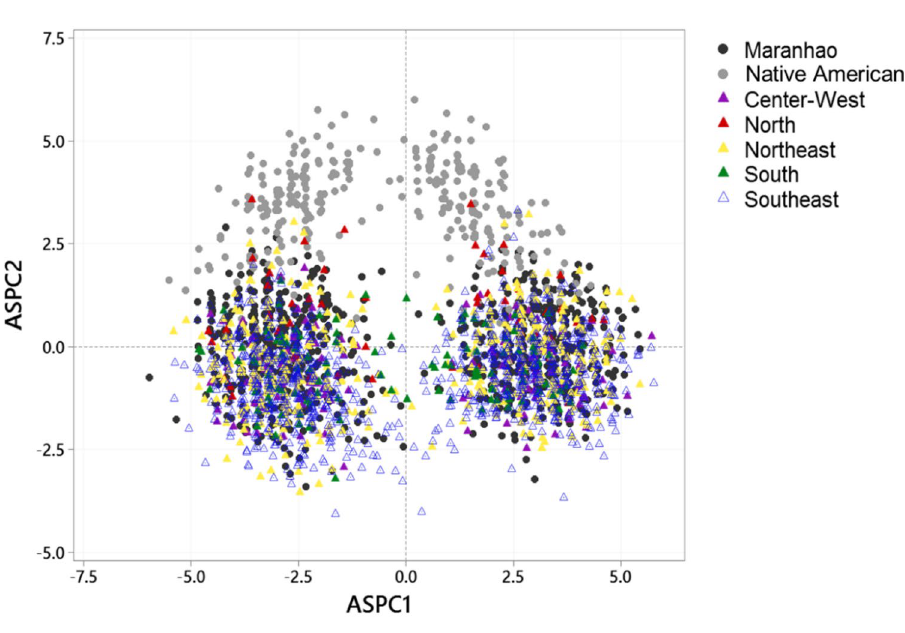
Figure 3. Ancestry specific by principal components analysis of admixed individuals and Brazilian reference groups. Brazilian Native American (Karitiana, Surui, Santa Isabel and Terena), and urban samples from Center-West (Mato Grosso do Sul), North (Amazonas), Northeast (Alagoas and Pernambuco), South (Paraná, Rio Grande do Sul, and Santa Catarina), and Southeast (Espírito Santo, Minas Gerais, Rio de Janeiro, and São